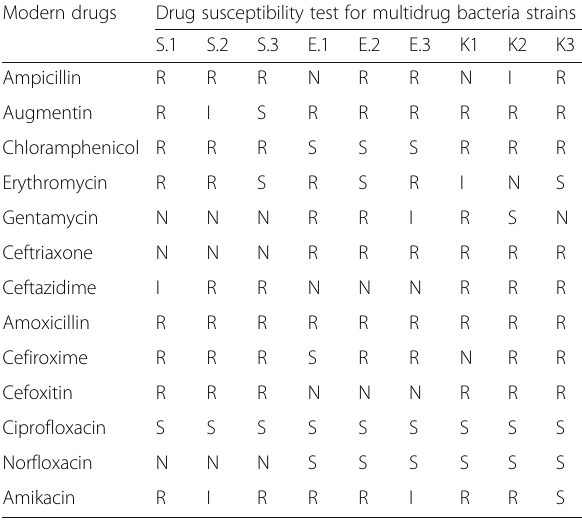
Table 1 Antibiotics resistant profile of multidrug resistant bacteria at AAU, 2018 Modern drugs Drug susceptibility test for multidrug bacteria